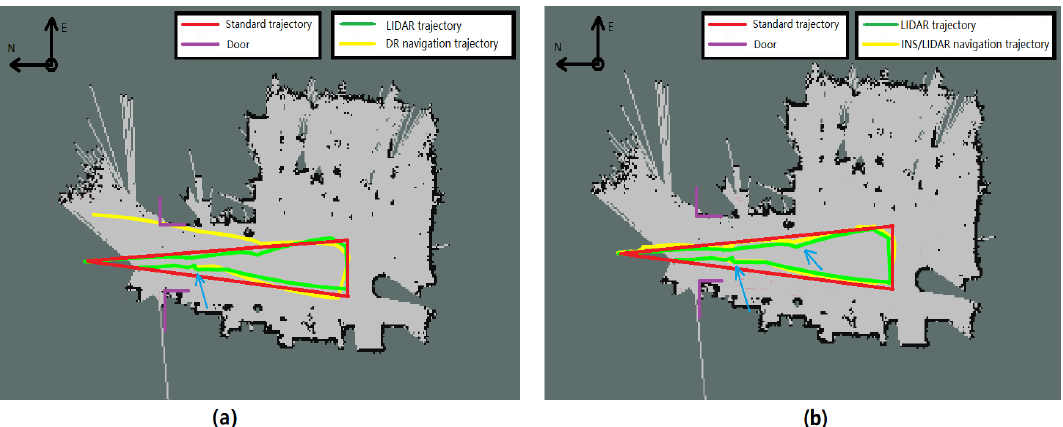
Figure 7. The comparison trajectory map of the integrated navigation algorithm (the first part of experiment 2). ( a ) The DR indoor navigation algorithm trajectory map ( b ) The INS/LIDAR indoor integrated navigation algorithm trajectory